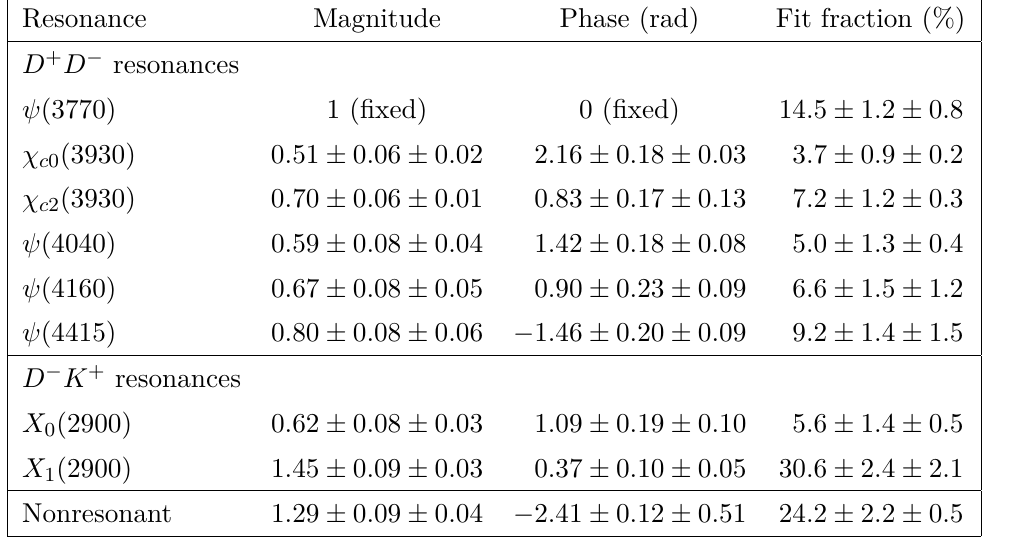
Table 1 . Fitfractions, amplitudes and phases of two-particle intermediate states in the amplitude analysis of the B + → D + D − K + decay in the LHCb [1]